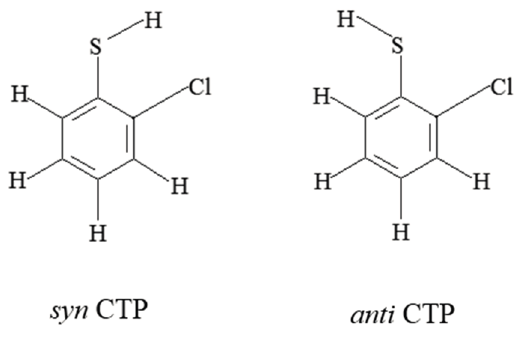
Figure 1. syn and anti conformers of